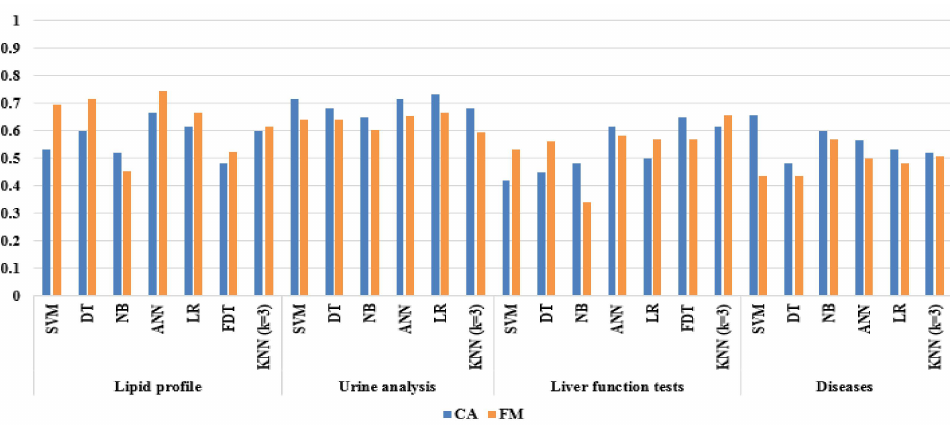
Figure 7. A comparison between CA and FM for base classifiers using wrapper FS (part 2).